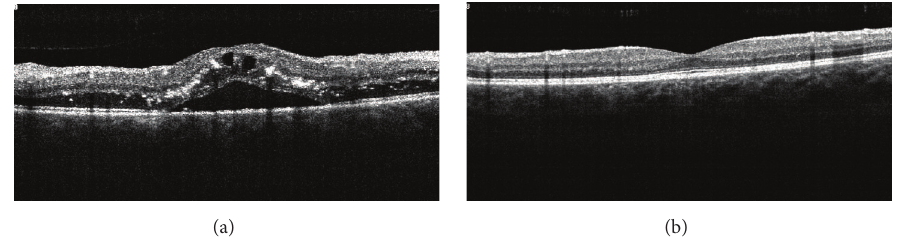
Figure3:Opticalcoherencetomography(RTVueOCT,Optovue,California,USA)oftherighteye:macularedema,withintraretinalcystsand subretinalfluid.Hyperreflectiveareaswithintheinternallayerscouldcorrespondtohardexudates(a).Followingtreatmentwithranibizumab, with complete resolution of the macular edema and neurosensory retinal detachment